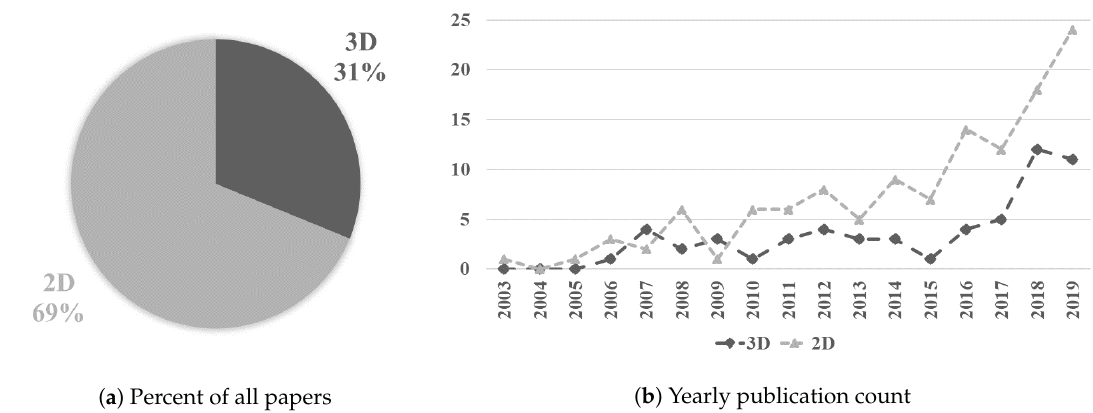
Figure 9. Distribution of papers for two-dimensional (2D) and three-dimensional (3D)